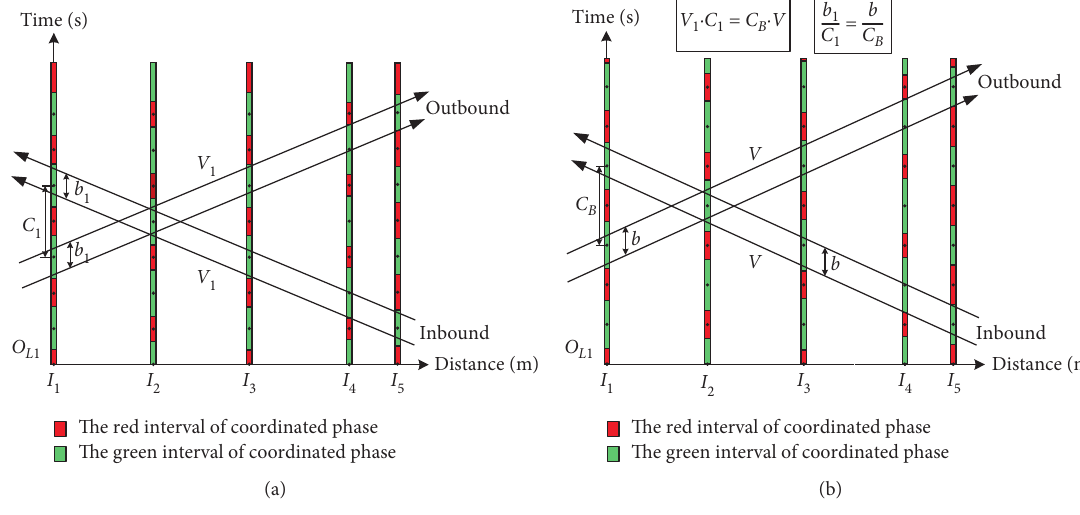
Figure 3: The vertical scaling of the time-space diagram. (a) Before the vertical scaling. (b) After the vertical scaling.